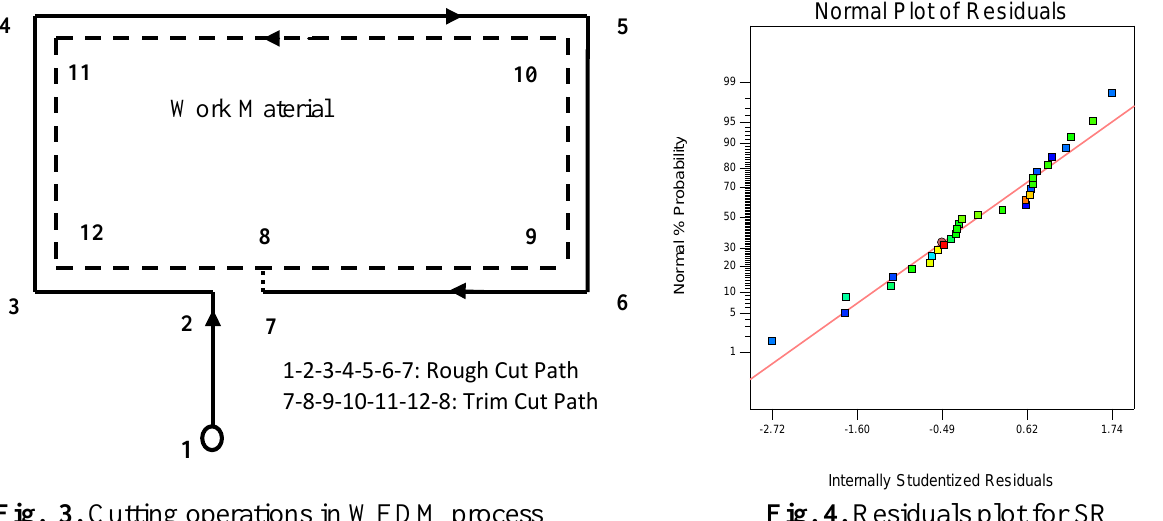
Fig. 3. Cutting operations in WEDM process Fig. 4. Residuals plot for